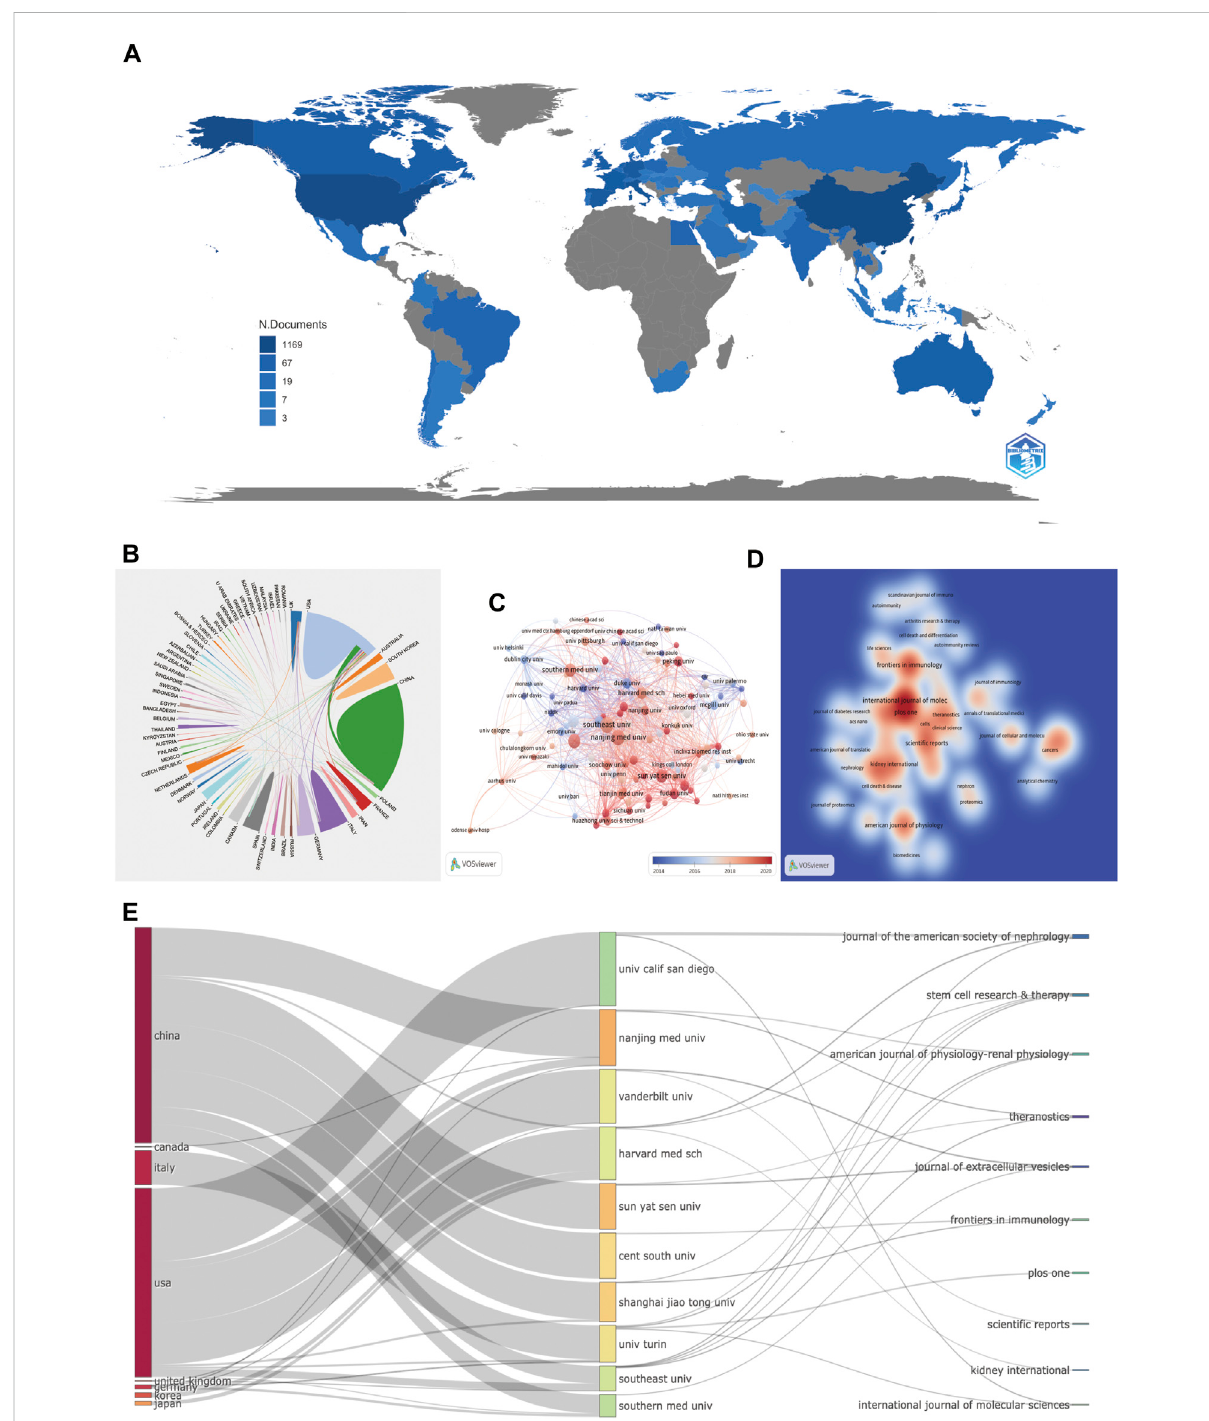
FIGURE 3 Countries, institutions, andjournalsrelatedto EVsinkidney diseasepublished worldwide. (A) Networkmapofthecountrydistributionbased on R for EVs in kidney disease. (B) Contributed countries cooperating based on an online bibliometric platform for EVs in kidney disease. (C) The chronologicalorderofinstitutionsproducedthearticlesbasedonVOSviewerforEVsinkidneydisease. (D) JournaldensitymapbasedonVOSviewer forEVsinkidneydisease. (E) Therelationshipofthecountries,institutions,andjournalsproducedarticlesbasedonanalluvial fl owmapbasedon R for EVs in kidney